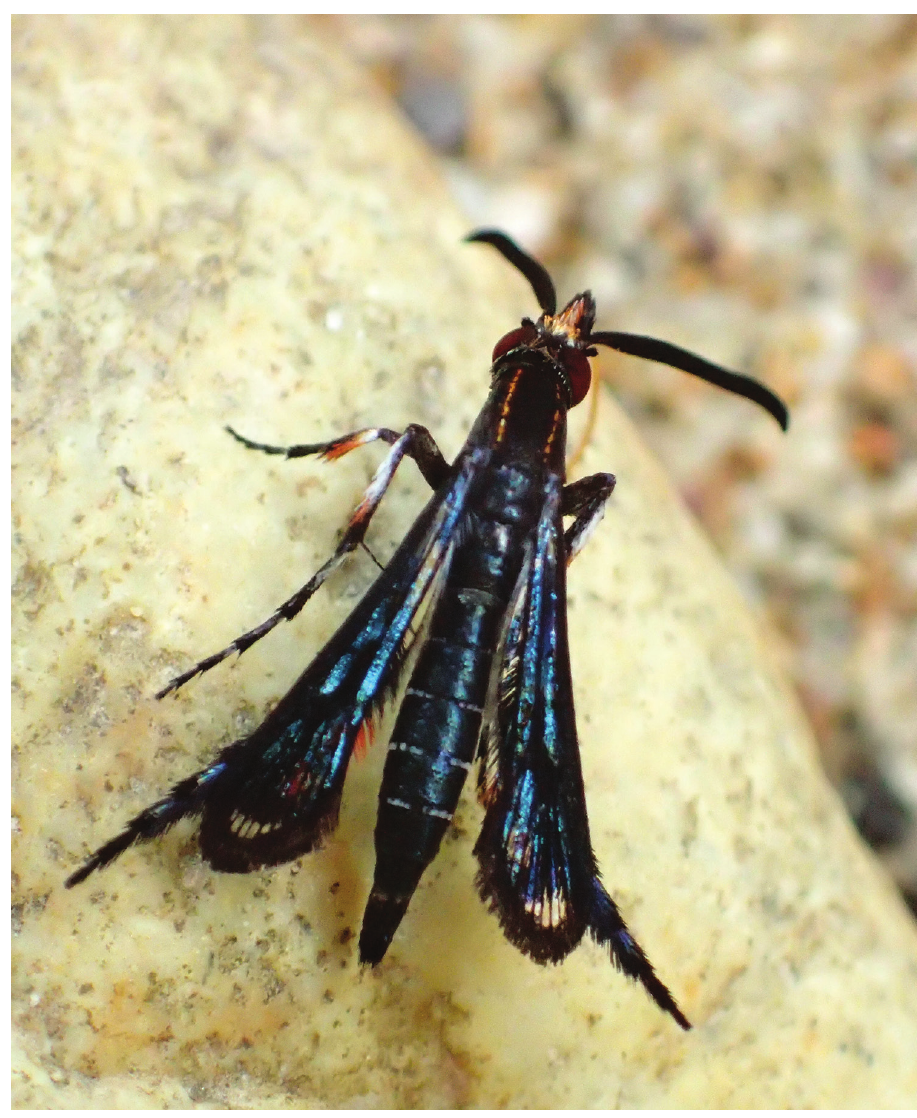
Figure 1. Pyrophleps ellawi has a strong blue sheen in sunlight. Representatives of this species vary in the number of orange scales on the thorax. The scales form two longitudinal stripes, either dashed or